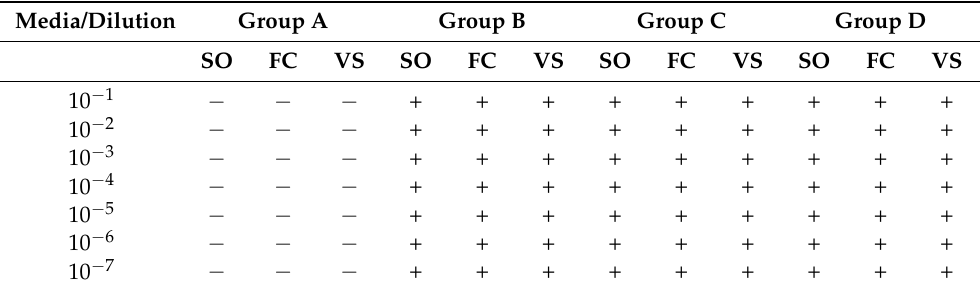
Table 2. Results of the determination of Listeria monocytogenes by the VIDAS ( n = 4 for each group of